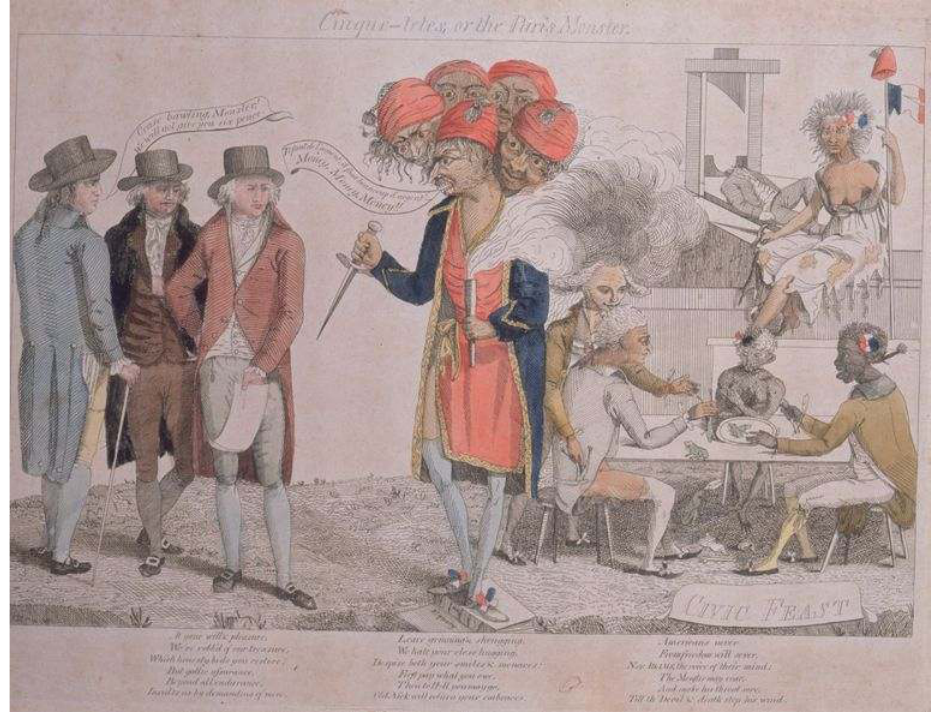
Cartoon satirizing the XYZ affair.